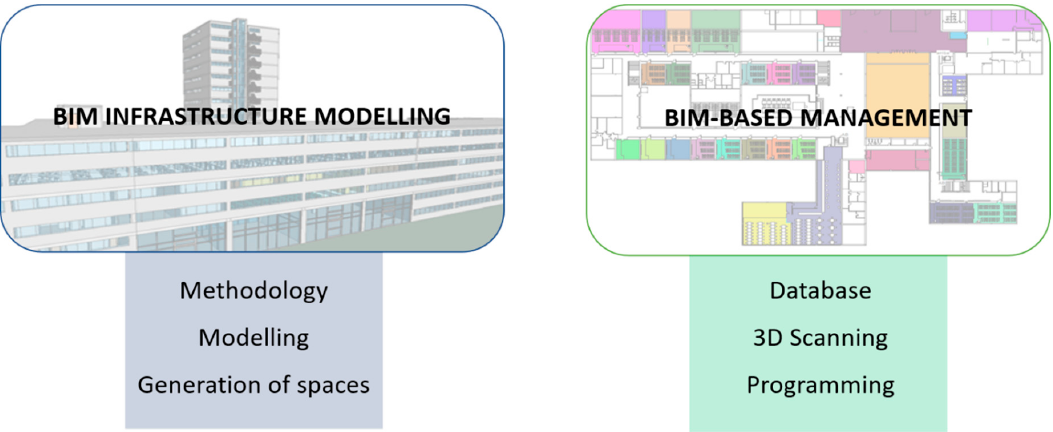
Figure 1. Flow chart Building Information Modeling (BIM)-EDU project.